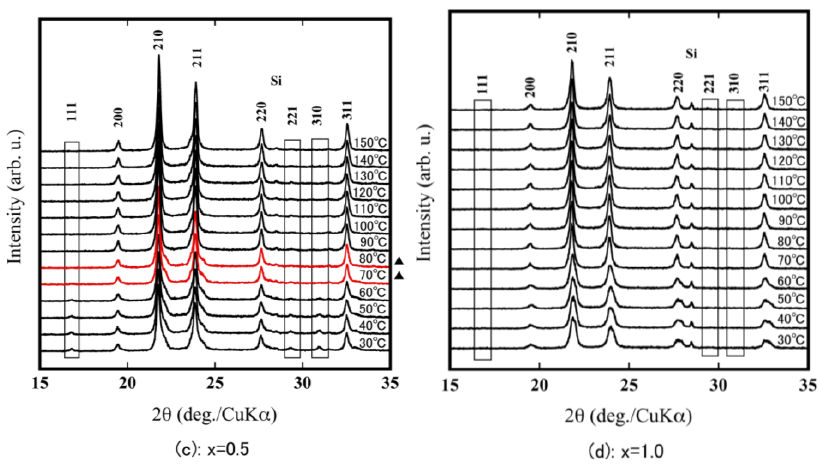
Figure 5. HT-XRD patterns of ZrW 2 − x Mo x O 8 sintered bodies ( a ): x = 0.0; ( b ): x = 0.2; ( c ): x = 0.5; ( d ): x = 1.0; ( ▲ : phase transition interval).